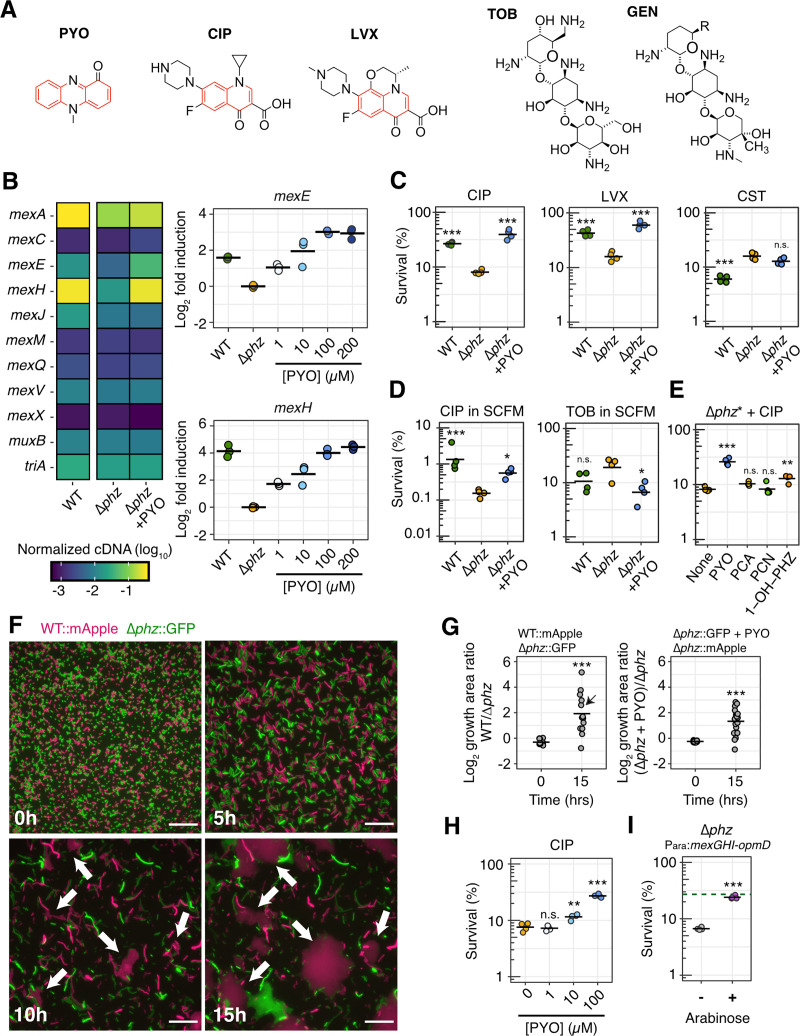
PYO induces expression of specific efflux systems, conferring cross-tolerance to fluoroquinolones.(A) Structures of PYO, 2 representative fluoroquinolones (CIP and LVX) and 2 representative aminoglycosides (GEN and TOB). PYO and fluoroquinolones are pumped by MexEF-OprN and MexGHI-OpmD, while aminoglycosides are not [21,22]. Rings with an aromatic character are highlighted in red. (B) Normalized cDNA levels for genes within operons coding for the 11 main RND efflux systems in P. aeruginosa (left; n = 3) and PYO-dose-dependent changes in expression of mexEF-oprN and mexGHI-opmD systems (right; n = 3). For full qRT-PCR dataset, see S1–S3 Figs. (C) Effect of PYO on tolerance to CIP (1 μg/mL), LVX (1 μg/mL), and CST (16 μg/mL) in GMM (n = 4). (D) Effect of PYO on tolerance to CIP (1 μg/mL) and TOB (40 μg/mL) in SCFM (n = 4). PYO itself was not toxic under the experimental conditions [16] (S4C Fig). WT made 50–80 μM PYO as measured by absorbance of the culture supernatant at 691 nm. See S5A Fig for experimental design. (E) Effect on tolerance to CIP (1 μg/mL) in GMM caused by the presence of the 4 main phenazines produced by P. aeruginosa (PYO, PCA, PCN, and 1-OH-PHZ) (n = 4). For this experiment, a Δphz* strain that cannot produce or modify any phenazine was used (see Methods). (F, G) Effect of PYO on lag during outgrowth after exposure to CIP in GMM. A representative field of view over different time points (F; magenta = WT::mApple, green = Δphz::GFP; see S1 Movie) is shown together with the quantification of growth area on the agarose pads at time 0 hour and 15 hours (G). For these experiments, a culture of each strain tested was grown and exposed to CIP (10 μg/mL) separately, then cells of both cultures were washed, mixed, and placed together on a pad and imaged during outgrowth. The pads did not contain any PYO or CIP (see Methods and S5D Fig for details). White arrows in the displayed images point to regions with faster recovery of WT growth. The field of view displayed is marked with a black arrow in the quantification plot. The results for the experiment with swapped fluorescent proteins are shown in S4E Fig. See S4C Fig for complementary data about effects of PYO on lag. Scale bar: 20 μm. (H) Tolerance of Δphz to CIP (1 μg/mL) in GMM in the presence of different concentrations of PYO (n = 4). (G) Tolerance of Δphz to CIP (1 μg/mL) in GMM upon artificial induction of the mexGHI-opmD operon with arabinose (n = 4). The dashed green line marks the average survival of PYO-producing WT under similar conditions (without arabinose). Statistics: C, D, E, H—1-way ANOVA with Tukey HSD multiple comparison test, with asterisks showing significant differences relative to untreated Δphz (no PYO); G, I—Welch unpaired t test (* p < 0.05, ** p < 0.01, *** p < 0.001, n.s. p > 0.05). In all panels with quantitative data, black horizontal lines mark the mean value for each condition. Individual data points represent independent biological replicates, except for in panel G, where the data points represent different fields of view. The data underlying this figure can be found in Table B in S1 Data. 1-OH-PHZ, 1-hydroxyphenazine; ANOVA, analysis of variance; CIP, ciprofloxacin; CST, colistin; GEN, gentamicin; GMM, glucose minimal medium; HSD, honestly significant difference; LVX, levofloxacin; PCA, phenazine-1-carboxylic acid; PCN, phenazine-1-carboxamide; PYO, pyocyanin; qRT-PCR, quantitative reverse transcriptase PCR; RND, resistance-nodulation-division; SCFM, synthetic cystic fibrosis sputum medium; TOB, tobramycin; WT, wild-type.